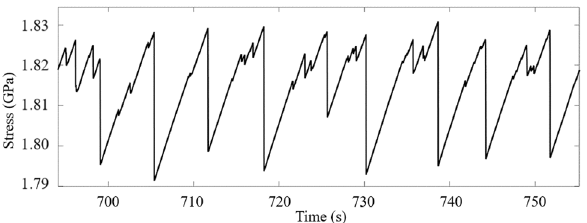
Figure 1. Experiment: The stress-time curve for uniaxial compression of a bulk metallic glass of composition Zr 45 Hf 12 Nb 5 Cu 15.4 Ni 12.6 Al 10 showing serrated flow. The sample is rectangular with a cross-sectional area of 2 mm by 1.5 mm and a length of 6 mm. The rapid decreases in stress are the avalanches. All visible avalanches are large; however, this behavior occurs over many orders of magnitude of stress drop size. “Small” avalanches are much smaller than is visible in this